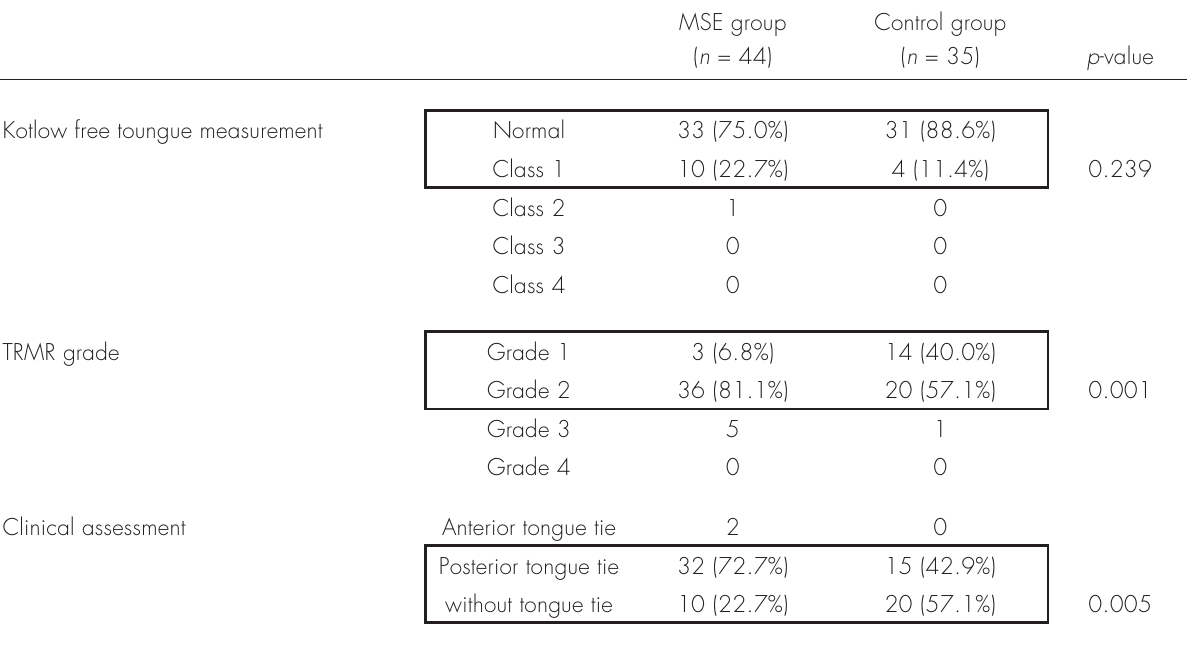
Table I. The intergroup comparison of proportion of each grade and clinical findings of tongue